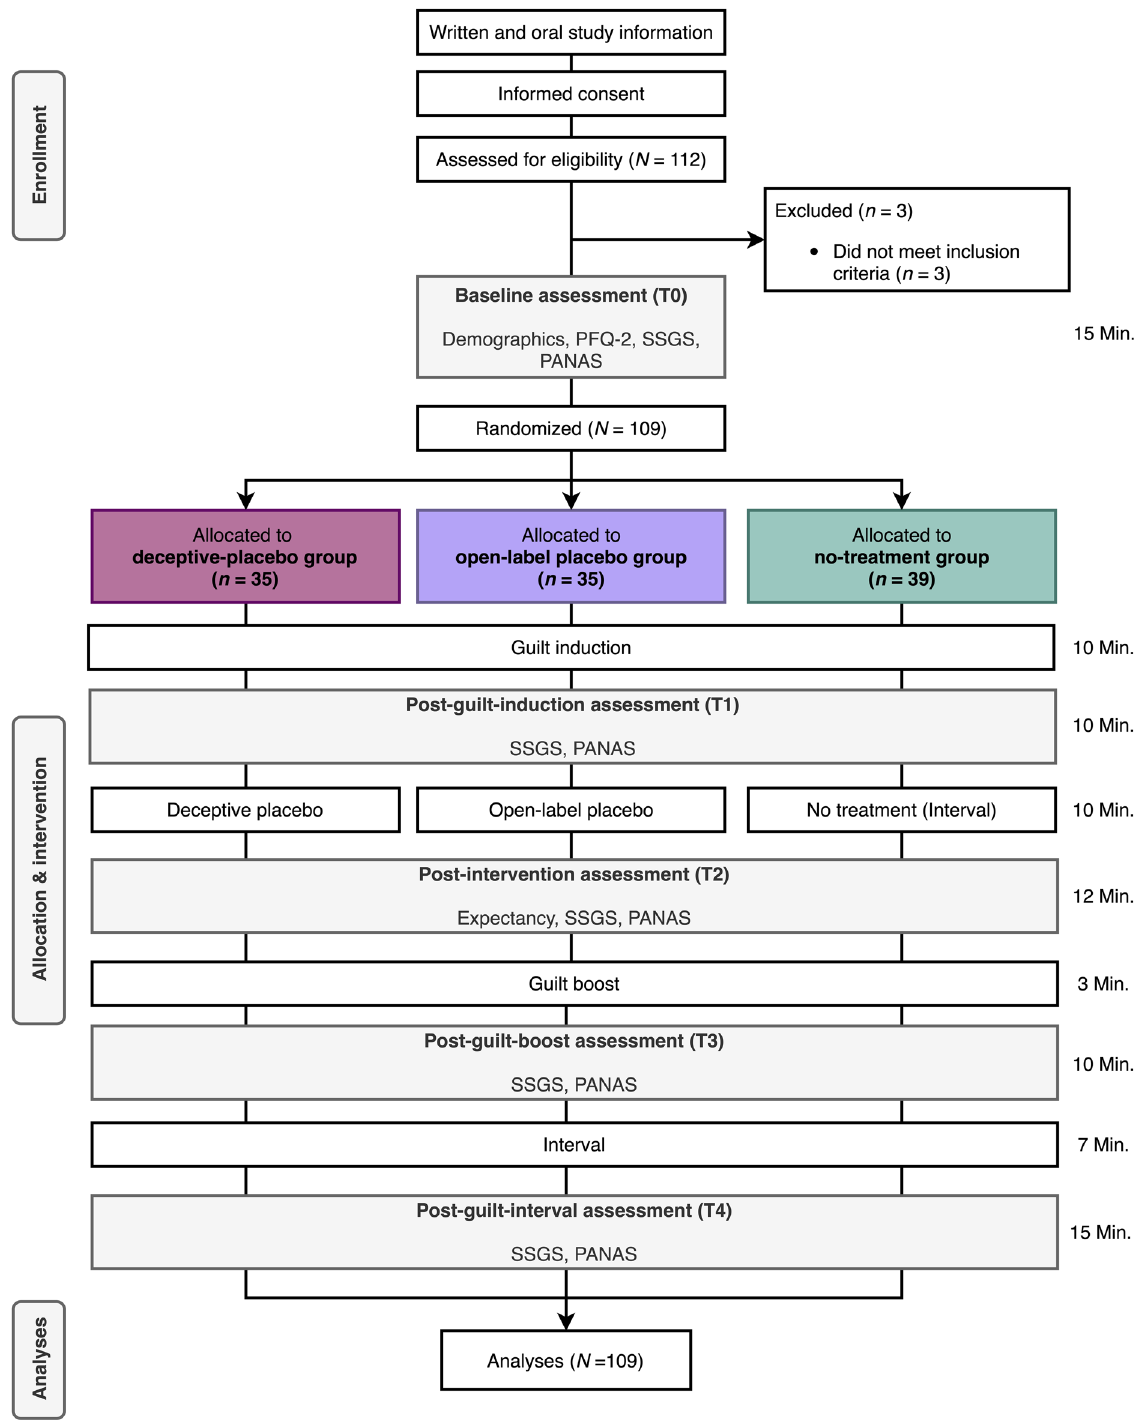
Figure 1. Study design and flow of subjects. Note: DP, deceptive placebo; OLP, open-label placebo; NT, no treatment; PFQ-2, Personal Feelings Questionnaire-2; SSGS, State Shame and Guilt Scale; PANAS, Positive and Negative Affect Schedule; CMQ, Context Model